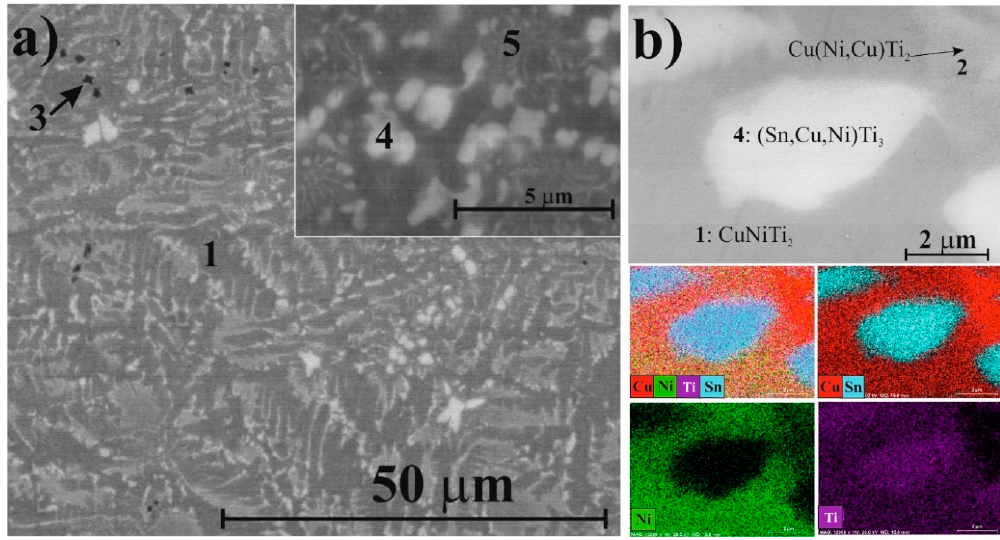
Figure 5. Backscattered SEM images ( a ) and characteristic compositional XEDS-SEM mapping of the same area ( b ) for the Ti 50 Cu 25 Ni 20 Sn 5 master alloy.